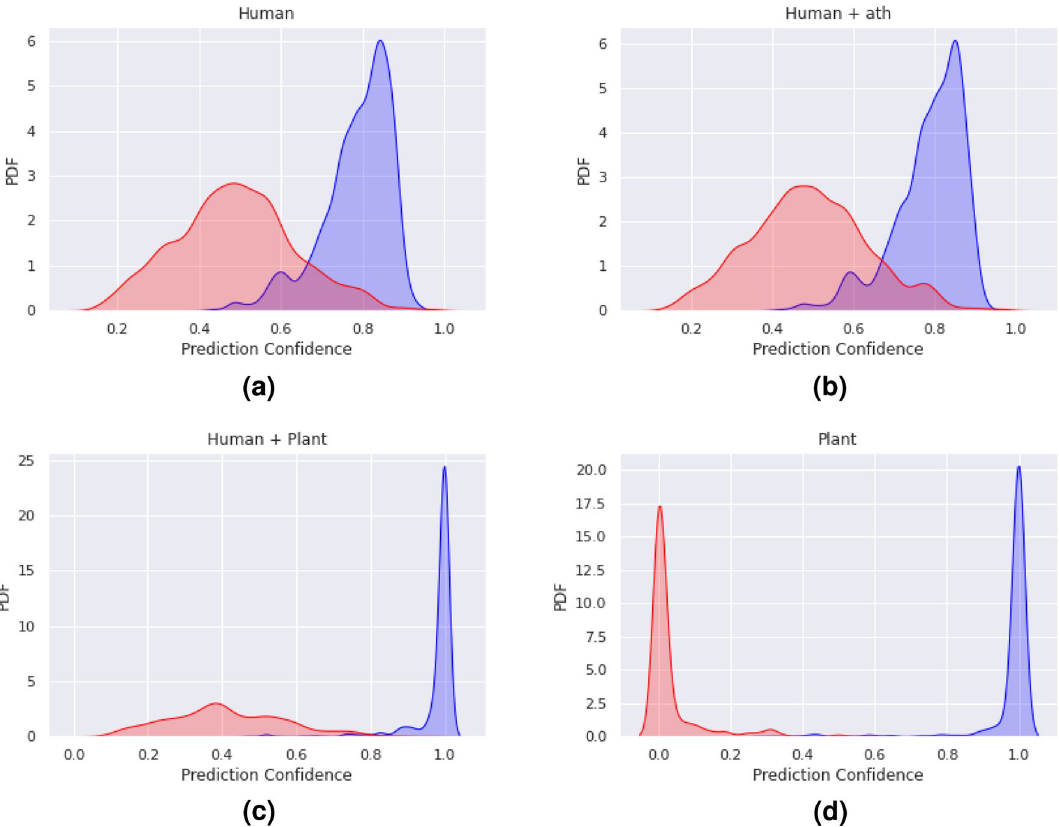
Figure 3. Density plots of the prediction scores of the four classifiers (Human, Human+ath, Human+Plant and Plant) on the gma test set. Here, prediction scores for negative test samples are shown in red, while positive test sample scores are shown in blue. A stronger classifier will lead to greater discriminability between the scores generated from positive and negative test miRNA:mRNA pairs.